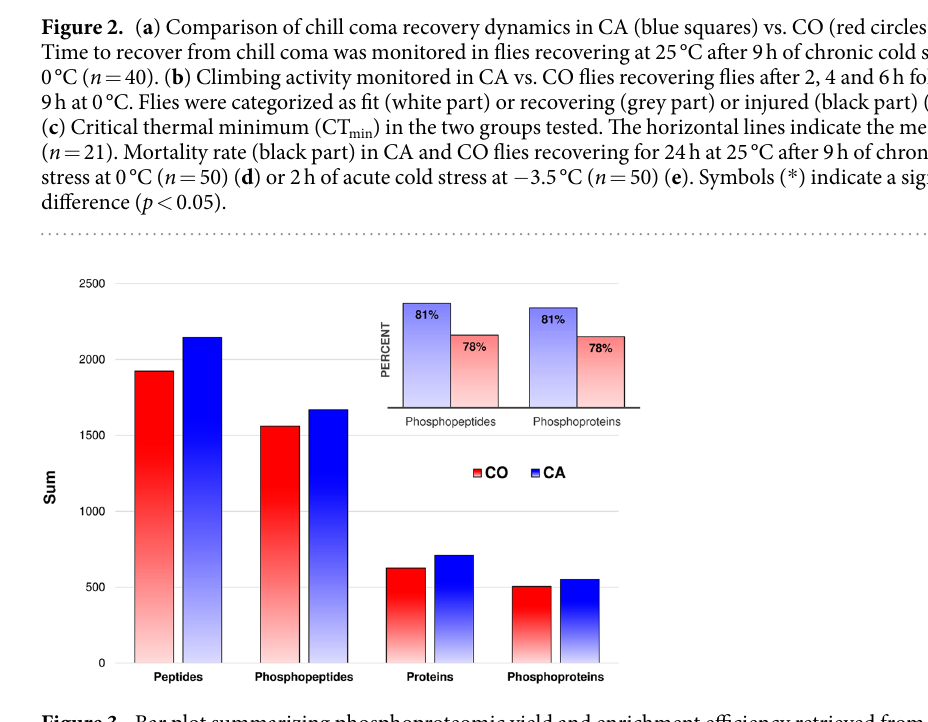
Figure 3. Bar plot summarizing phosphoproteomic yield and enrichment efficiency retrieved from the inference lists created at peptide and protein level for CA (blue) and CO (red) treatments. The bars show the total number of non-redundant identified peptides, phosphopeptides, and the corresponding number of identified proteins and phosphorylated proteins. The figure on top right shows the efficiency of enrichment corresponding to the ratio of phosphopeptides over peptides and phosphoproteins over proteins for CA (blue) and CO (red)